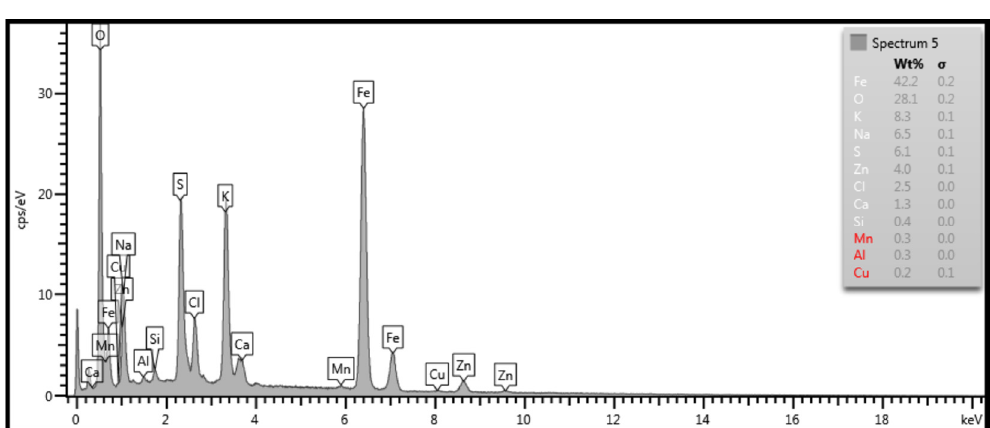
Figure 16. Spectrum 4 according to Figure 15; SEM.